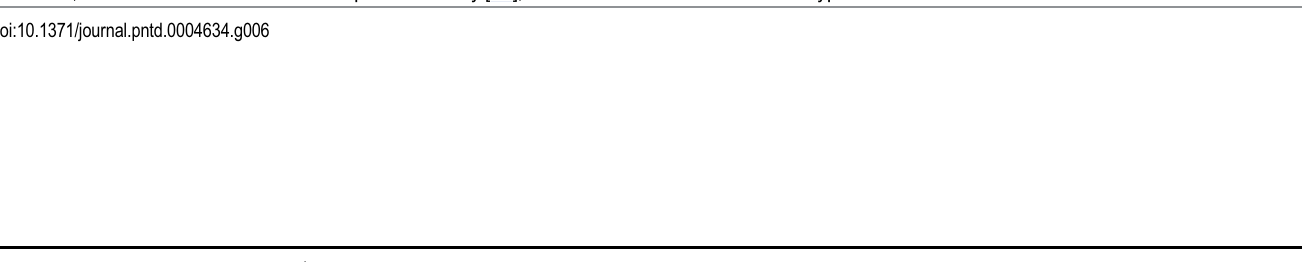
PLOS Neglected Tropical Diseases | DOI:10.1371/journal.pntd.0004634 April 19, 2016 17 /